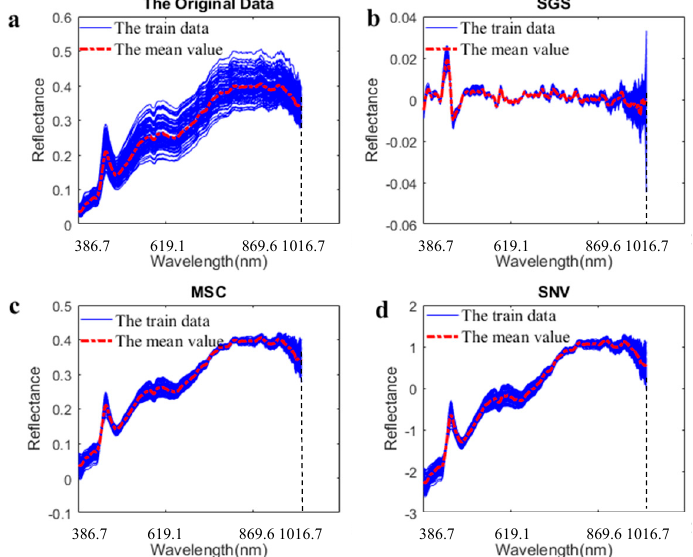
Figure 5. Spectral reflectance of seeds of Zhengdan 958. ( a ) The original data and the data preprocessed by ( b ) Savitzky-Golay Smoothing, ( c ) multiplication scatter correction, and ( d ) standard normal variate.